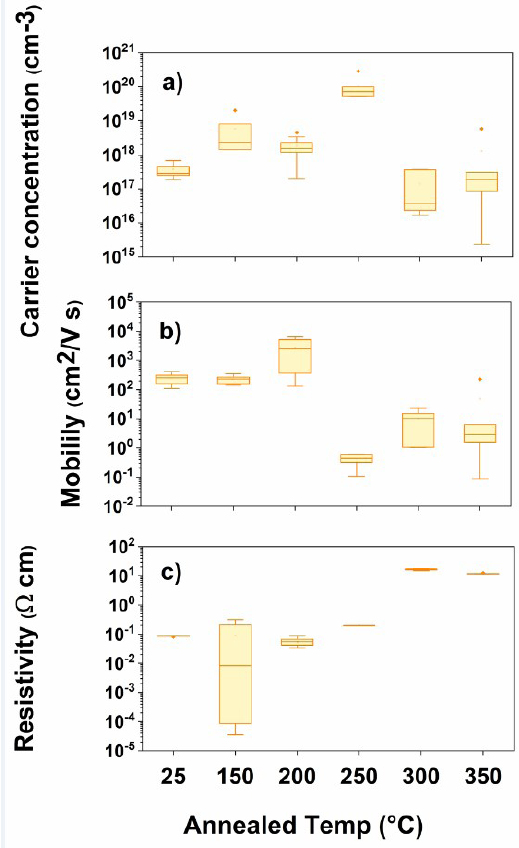
Figure 9. Hall effect results for the nitrogen-sulfur annealed layers of Bi S at different temperatures a) carrier density, b) mobility 2 3 and c)